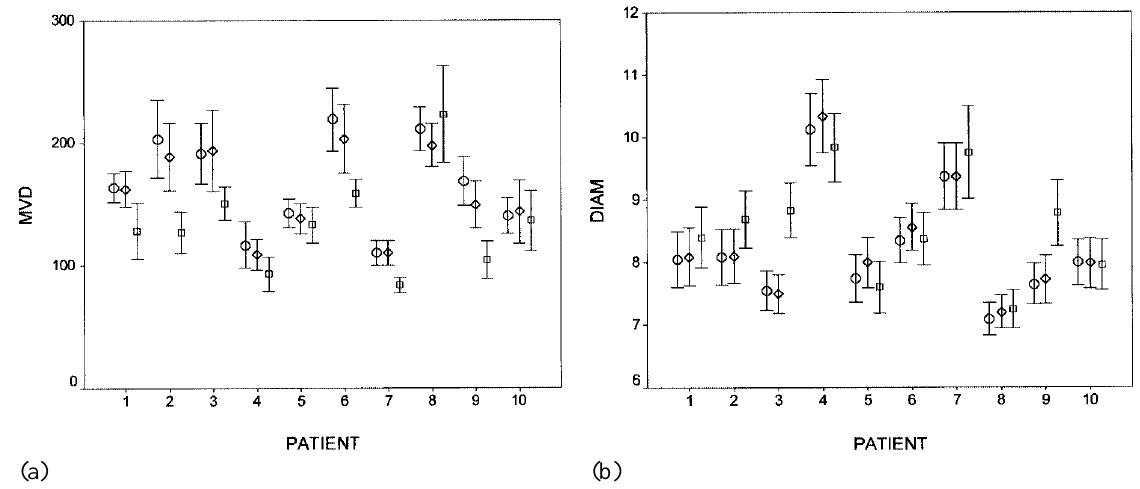
Fig. 2. Interobserver reproducibility for the interactive correction step and the systematic sampling of microvessel density and vessel diameter for 10 patients with a tongue carcinoma. For each patient, the mean values and 95% confidence intervals of the microvessel density (MVD) (a) and DIAM (b) obtained from the 10 highest vascularised fields found by sampler 1 and corrector 1 ( ◦ ), sampler 1 and corrector 2 ( (cid:1) ), sampler 2 and corrector 2 ( (cid:3)